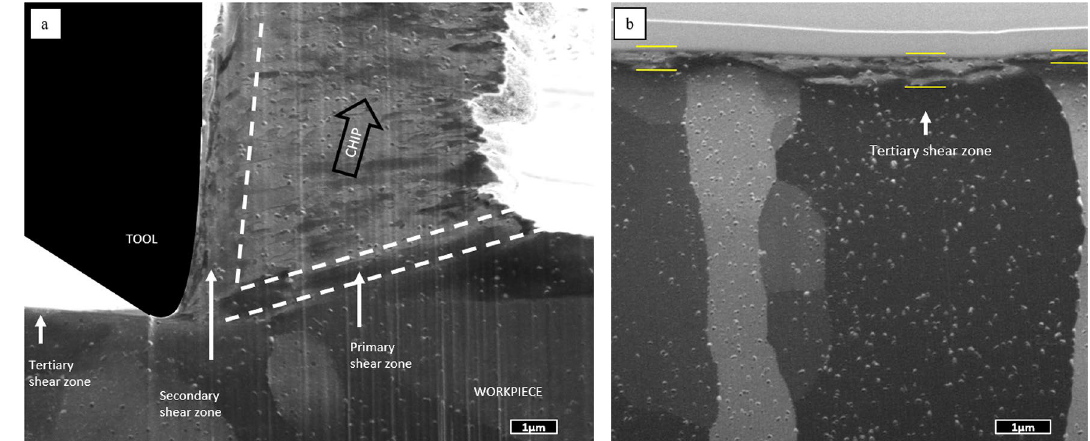
Figure 3. ( a ) Cross-section of a chip on a workpiece cut with 1 µm feed and 0.6 mm/min imaged by channelling contrast in FIB. ( b ) Detail of the size of tertiary shear zone after cutting action on grains with different orientation.